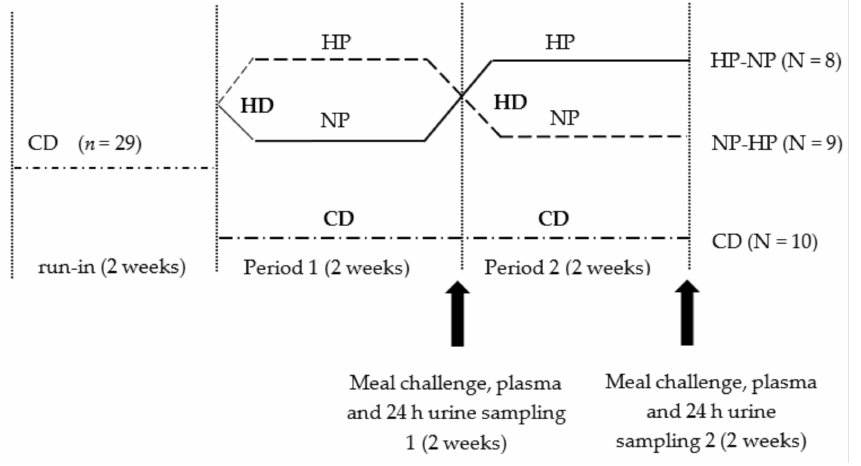
Figure 1. Study design. All participants started on a two-week run-in period on a weight maintaining control diet (CD, 27.8 En% fat; 16.9 En% protein; 55.3 En% carbohydrate). Thereafter, participants were randomly assigned to either the high-fat-hypercaloric diet group (HD; n = 19) or to the reference group consuming a control diet (CD; n = 10) for the following 4 weeks of intervention. Participants in the HD-group were overfed with 2 MJ per day. The HD intervention consisted of a of a 2 × 2-week cross-over design with two separate periods: a 2-week high-protein intervention (HP, 37.7 En% fat; 25.7 En% protein; 36.6 En% carbohydrates) and a 2-week normal-protein intervention (NP; 39.4 En% fat; 15.4 En% protein; 45.2 En% carbohydrates). We collected 24 h urine samples at the end of periods 1 and 2, a meal challenge with blood sampling was performed after period 1 and 2. HD—high-fat hypercaloric diet; CD—control diet; HP—high protein condition (within high-fat hypercaloric diet); NP, normal protein condition (within high-fat hypercaloric